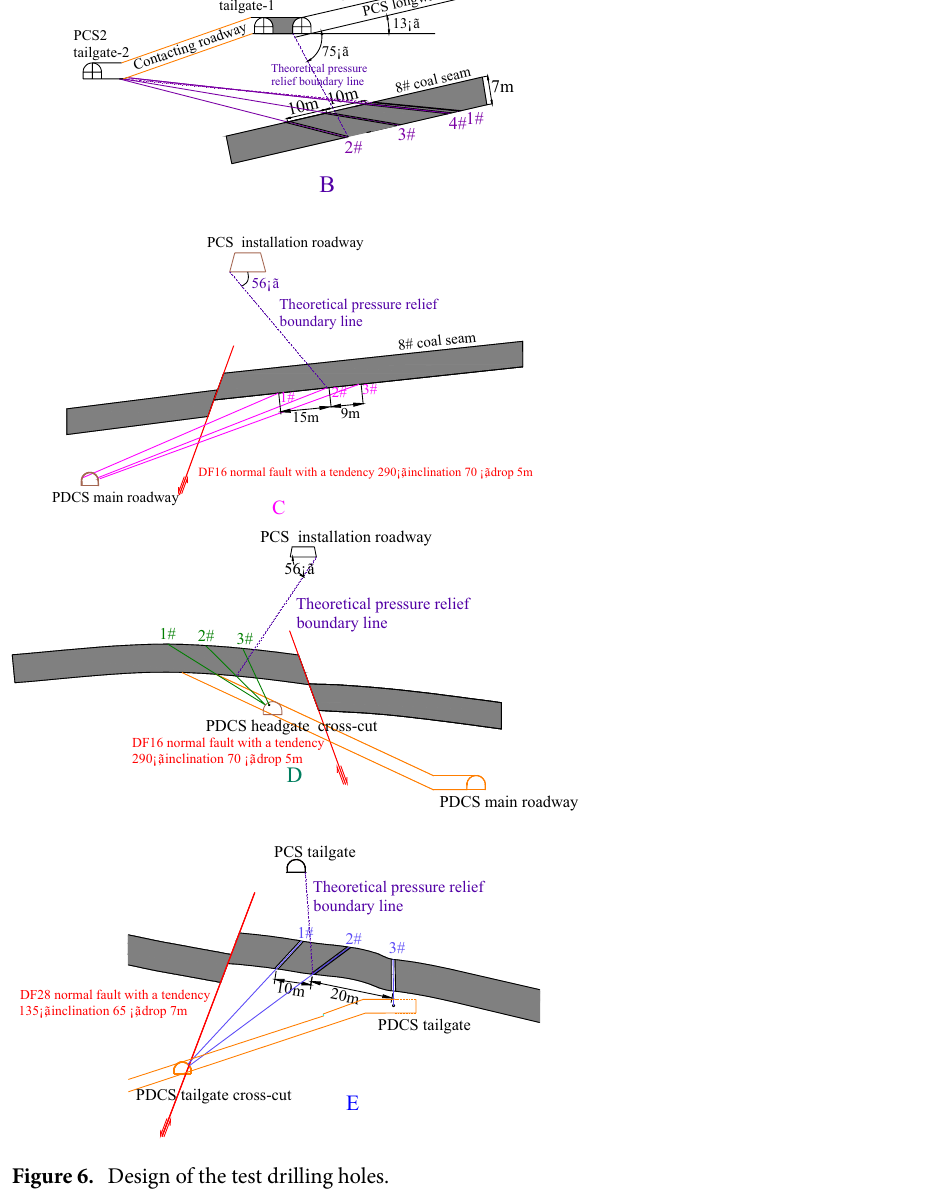
Figure 6. Design of the test drilling